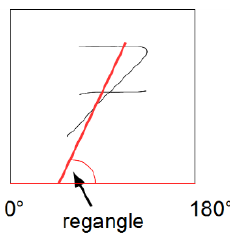
Figure 7. Representation of the parameter “REGANGLE” .